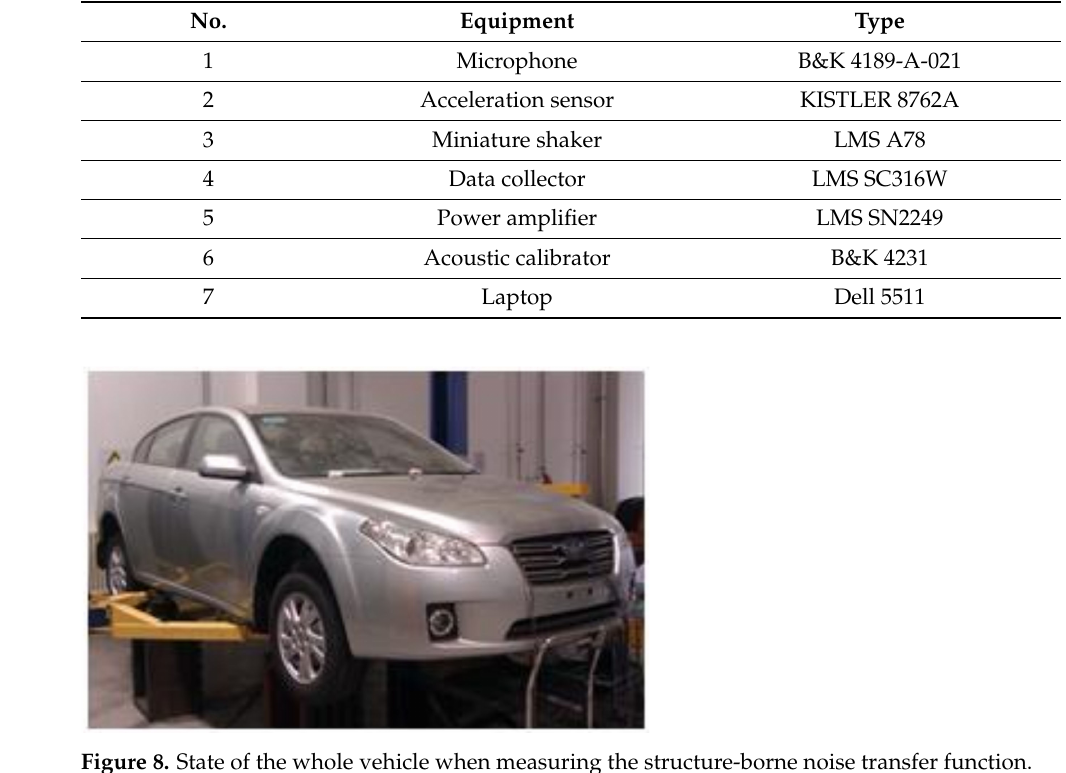
Table 2. Structure-borne noise transfer function measurement equipment.